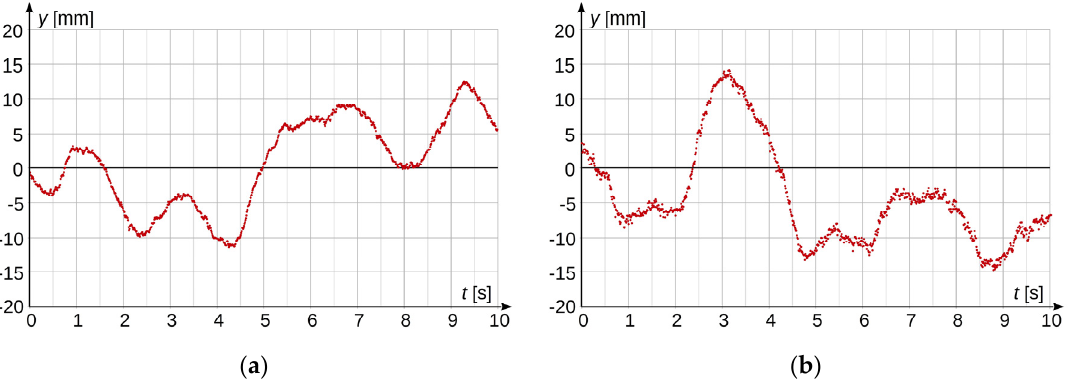
Figure 11. Measurement results of vertical movements of an HV overhead power line conductor; ( a ) for optimal brightness level; ( b ) for brightness level lower by 1.5 EV than the optimal.